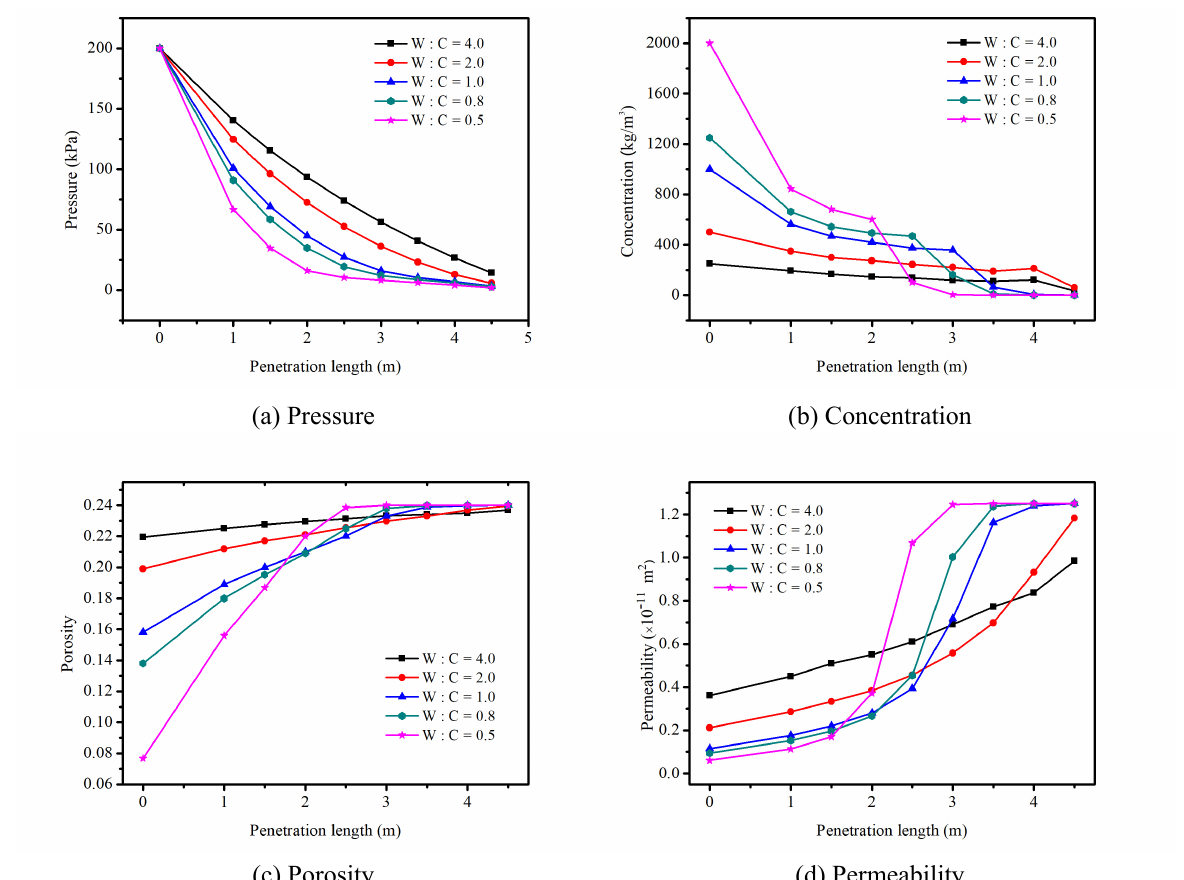
Figure 7. Influences of the water–cement ratio on the pore pressure, concentration, porosity and